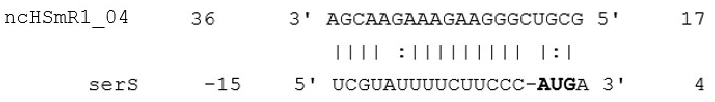
in the RBS region of the latter.